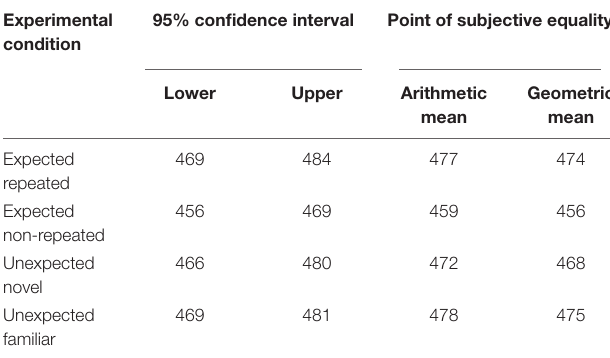
TABLE 1 | 95% confidence intervals for the point of subjective equality of duration (ms) in each experimental condition and the respective arithmetic and geometric mean (Experiment